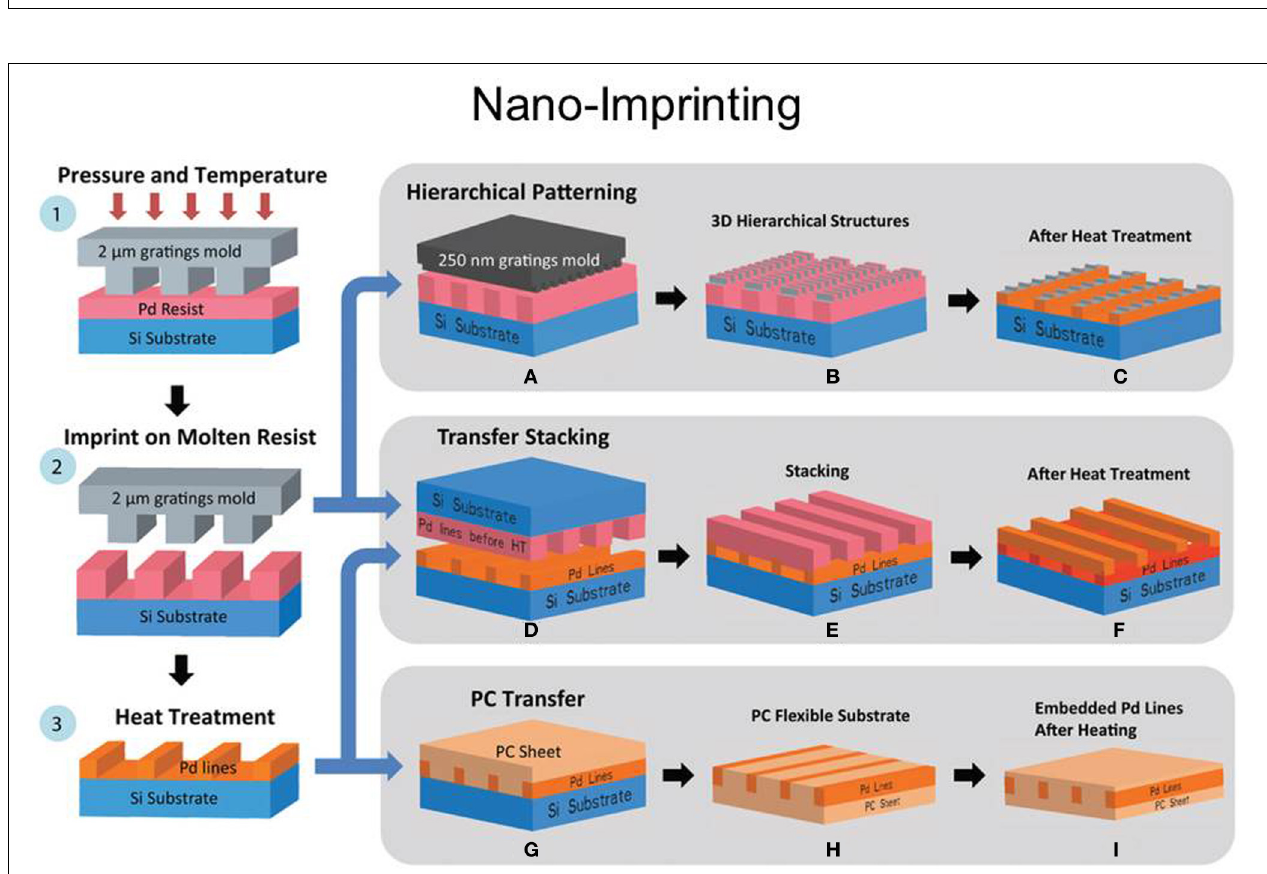
FIGURE 7 | Illustration of imprinting technique using a Si mold. A Pd benzylthiolate film was spin coated on Si substrate and imprinted at temperatures close to its melting point ( 120ˇrC) by applying pressure. During this process, the pattern of the mold is imprinted (2) and cooled down. After de-molding (3), the patterns on the Si substrate were heat treated to obtain the final Pd patterns. During stage 2, there are a few other patterning